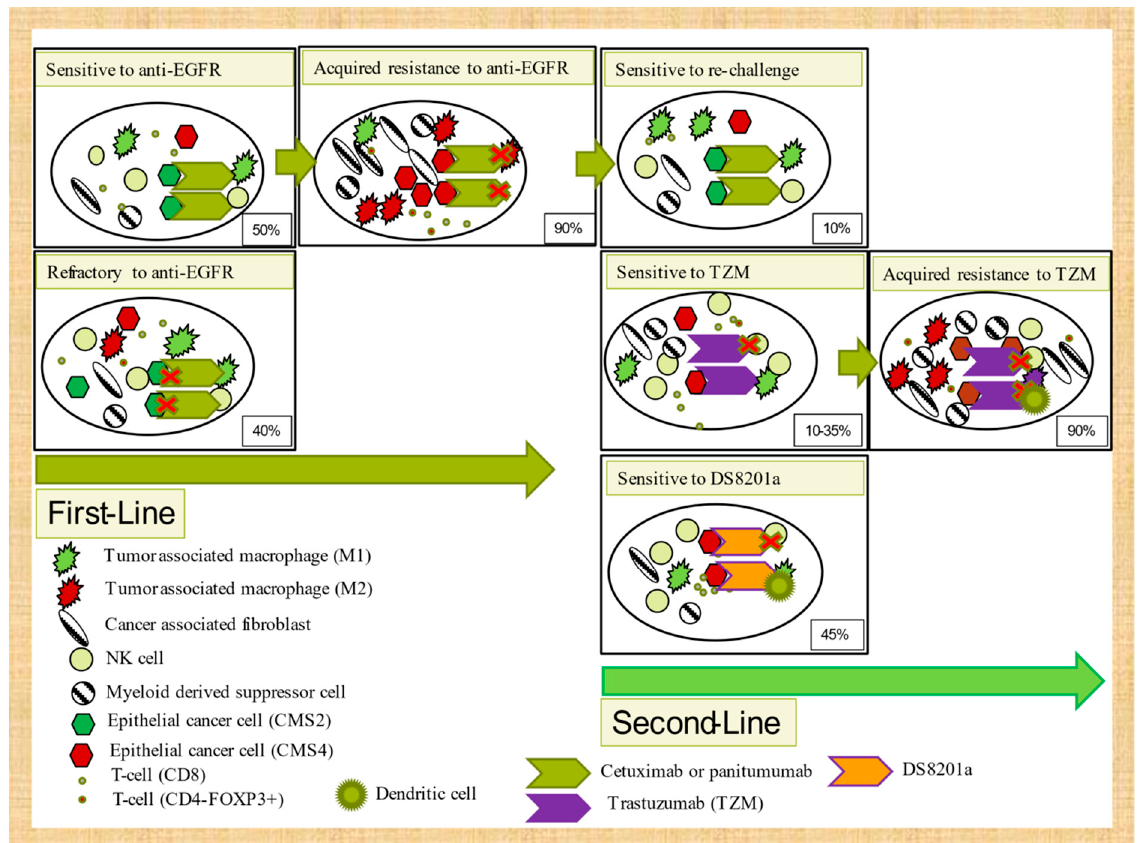
Figure 2. Tumor microenvironment mechanisms of intrinsic and acquired resistance to targeted therapies in 2WT RAS/BRAF colorectal cancer.